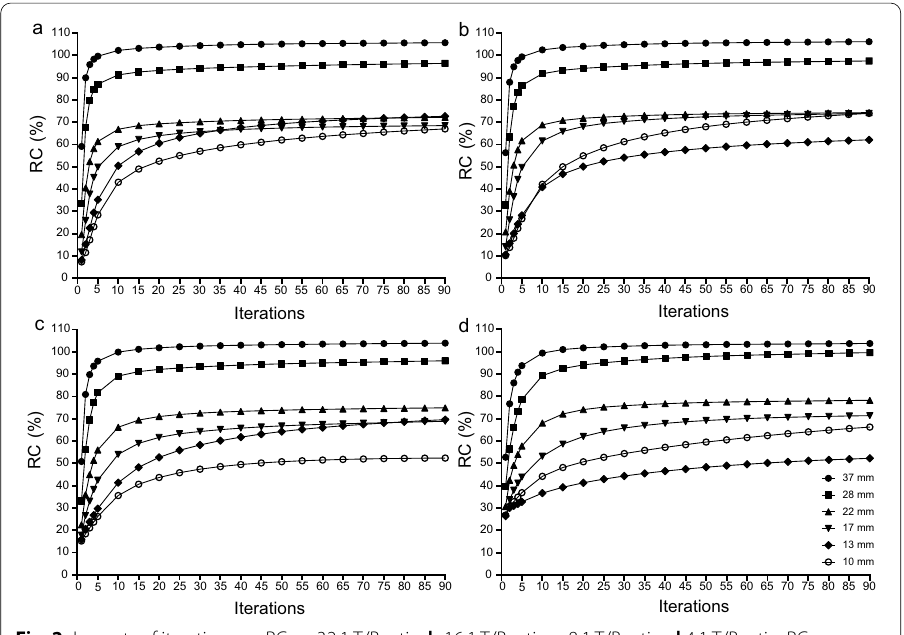
Fig. 2 Impacts of iterations on RCs. a 32:1 T/B ratio; b 16:1 T/B ratio; c 8:1 T/B ratio; d 4:1 T/B ratio; RCs were calculated with 1–90 iterations; Fixed reconstruction parameters: six subsets, no filter, AC combination; Fixed acquisition parameters: 120 s/frame of acquisition time, 15% energy